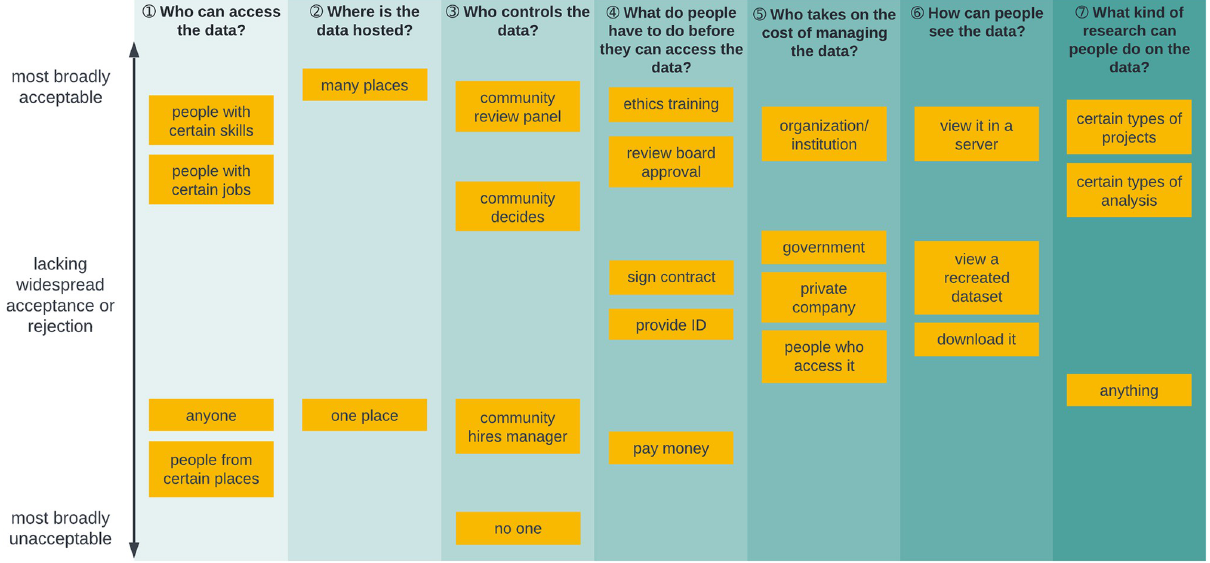
Fig 6. Aggregate deliberative outputs regarding acceptability and level of